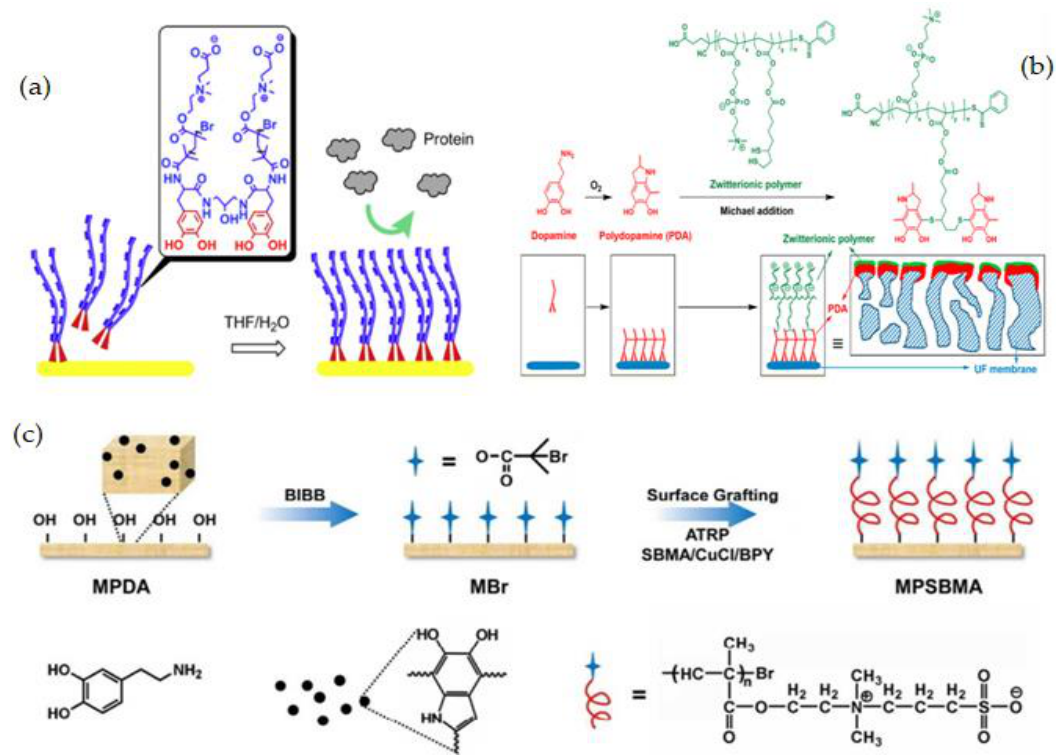
Figure 11. ( a ) Au surface grafted with pCB2-catechol2-Direct modification method [183], ( b ) Sche- matically preparation of PES modified ZWs using PDA as a Bio-glue intermediate layer [71], ( c ) Grafting of PSBMA zwitterions onto PVDF/PDA blend membrane via PDA-ATRP [191].